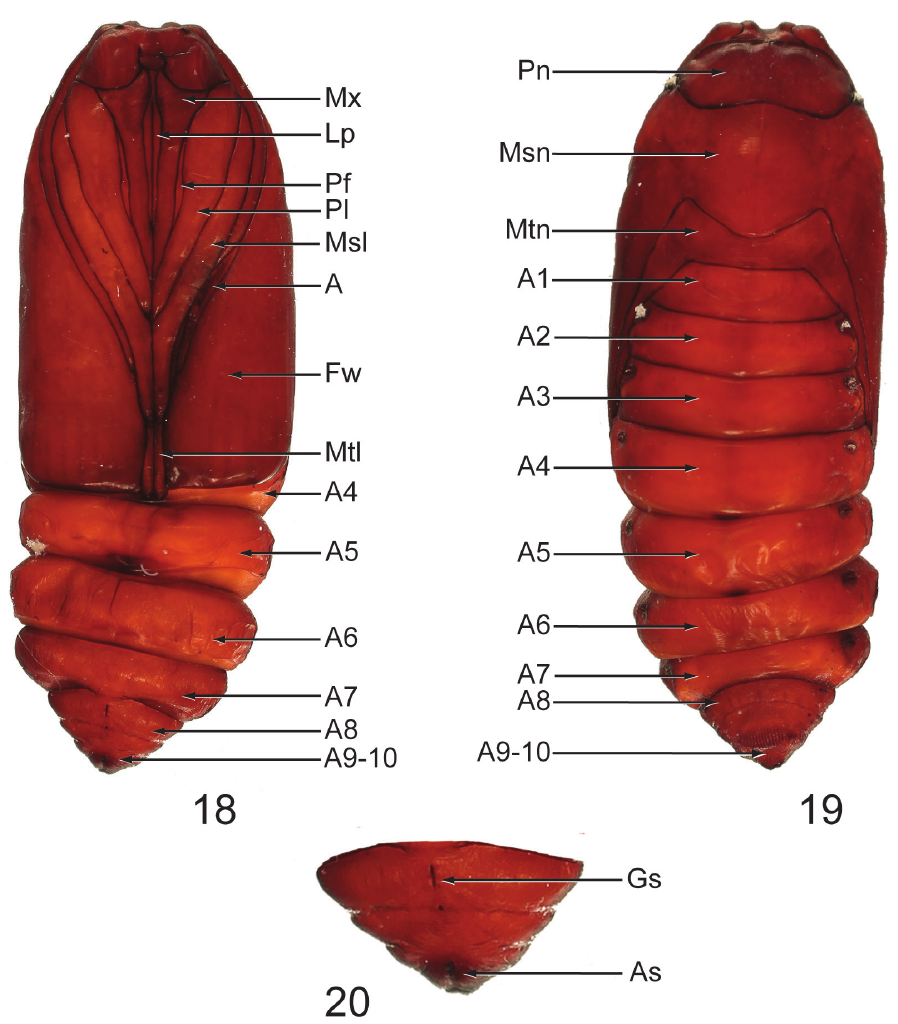
Figures 18–20. Female pupa of Gadirtha fusca sp. n. (preserved in alcohol). 18 dorsal 19 ventral 20 clo- seup of A8–A10 ( A antenna; As anal suture; Fw forewing; Gs genital suture; Lp Labial palp; Msl meso- thoracic leg; Msn mesonotum; Mtl metathoracic leg; Mtn metanotum; Mx maxillae; Pf prothoracic femur; Pl prothoracic leg; Pn